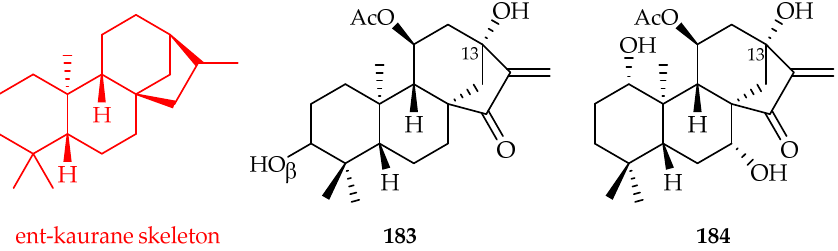
Figure 75. Structures of ent -kaurane skeleton, 3-e pi -isodopharicin A 183 [120], and scopariusol C 184 [120].